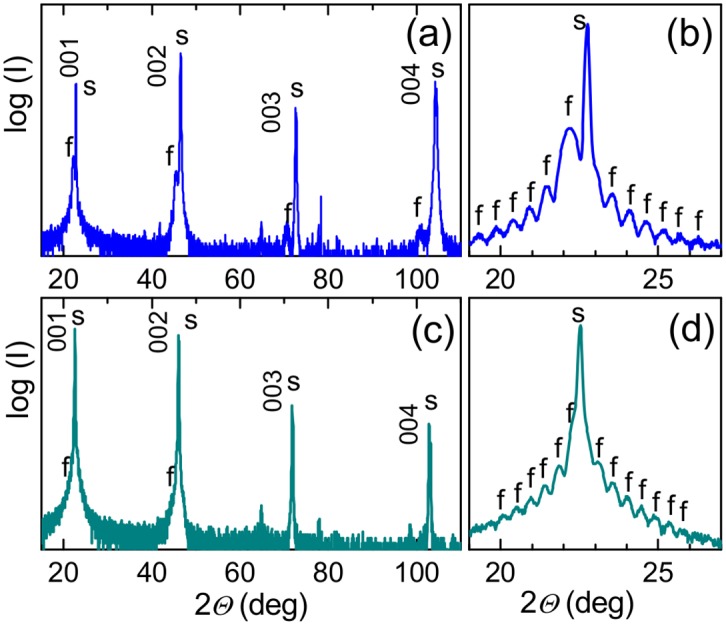
Θ-2Θ x-ray diffraction patterns in the KNNO films on (a,b) SrTiO3(001) and (c,d) DyScO3(011) substrates.Diffractions from the substrates and films are marked by s and f, correspondingly. Panels (b,d) show scans around (002) diffractions.